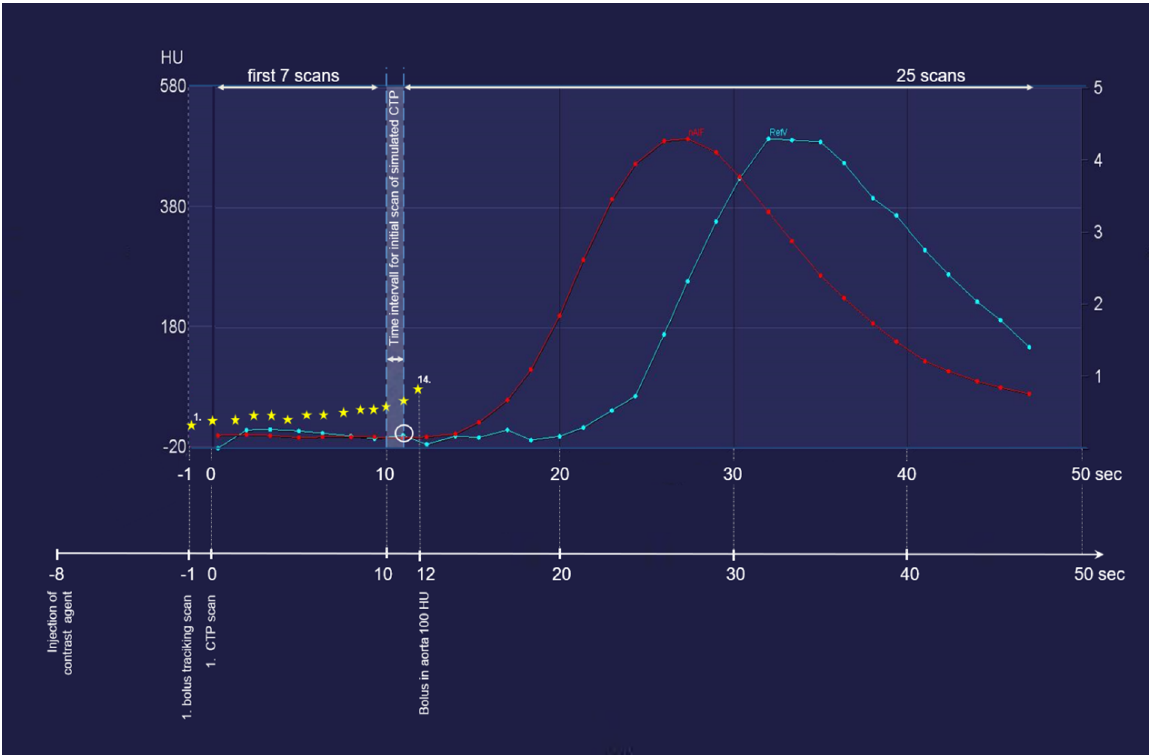
Figure 2. With the aid of an example, this figure explains the method of identifying the first scan of the simulated data sets. The CT attenuation values of the bolus tracking scan are marked with *. The x axis indicates the time passed after the contrast agent injection. The y axis represents the corresponding attenuation values. In the simulated CTP examinations, the initial scan was set to at least 1 s but not more than 2 s before the time at which the contrast agent bolus approached the threshold value of 100 HU in the ascending aorta. This means that if the contrast agent reached the threshold value (for example, 20 s after injection), the first CTP scan should be chosen around 18 sec after injection, corresponding to the 8th scan acquired at 19 s after the contrast agent injection in this case. nAIF: arterial inflow peak; RefV: venous inflow peak.